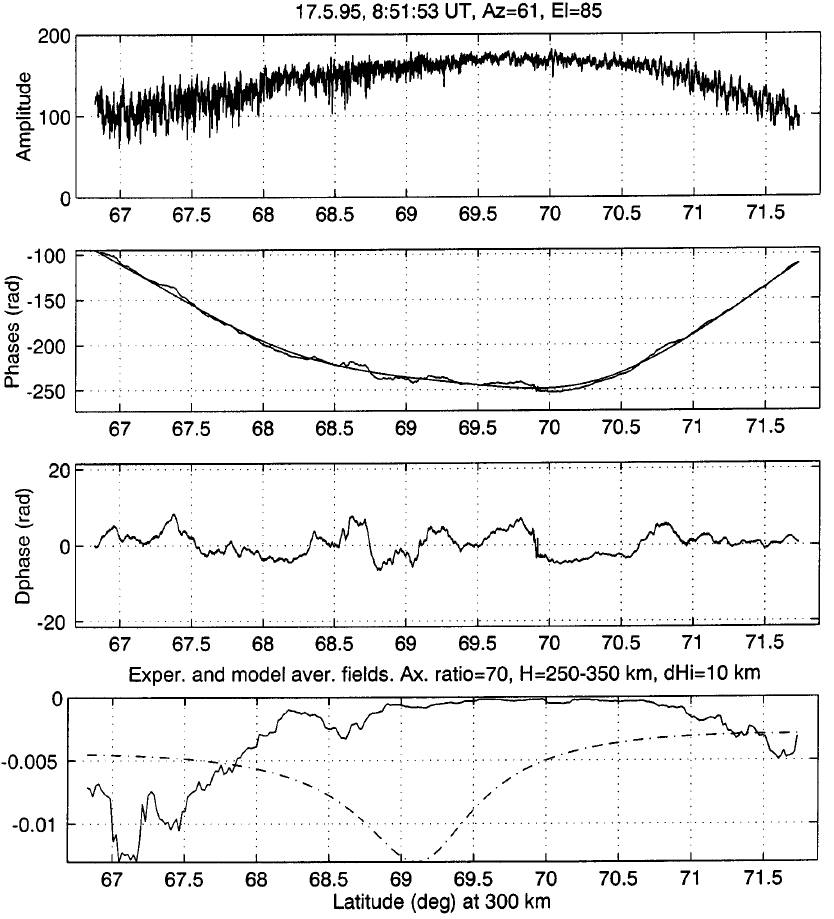
Fig. 1. Experimental and modelling results for the satellite record made about 2 h before heating. The top panel presents the measured amplitude of the satellite signal. The time at the top indicates the start time of the record, Az and El are the azimuth and elevation of the satellite’s closest approach as seen by the receiver. The second panel from the top shows the measured phase and its approxi- mation (the smooth curve ) obtained by low- pass filtering with 0.01 Hz cut-o(cid:128). The di(cid:128)erence between the measured total elec- tron content and its approximation is shown in the third panel . The solid curve of the 4th panel represents the experimental X -value and the dashed curve shows the model of X calculated using a flat ionospheric layer of a constant electron density variance between the heights of 250–350 km with the axial ratio (cid:97) (cid:136) 70 of the irregularities along and perpendicular to the magnetic field. The value dHi (cid:136) 10 km is the integration step. The latitudinal scale of the x -axes for all the panels is fixed to the height of